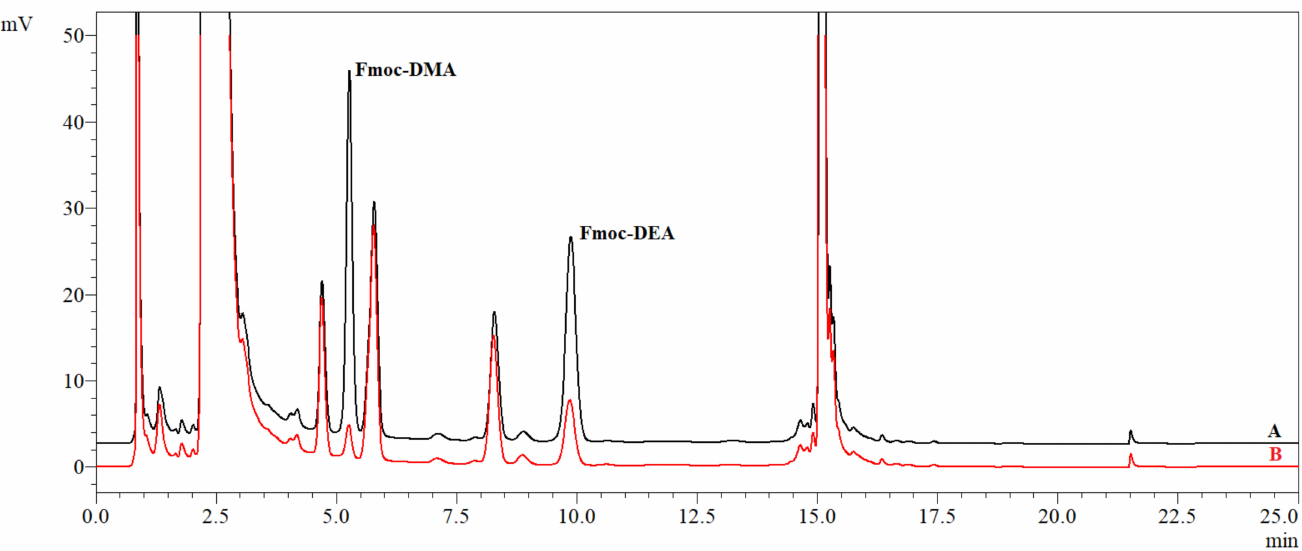
Figure 5. Chromatogram of the 1- µ g/g standard solution of nitrosamines ( A ) and the blank sample ( B ) after derivatisation with Fmoc-Cl (fluorescence detector, excitation: 265 nm, emission: 313 nm; chromatographic conditions as in Table